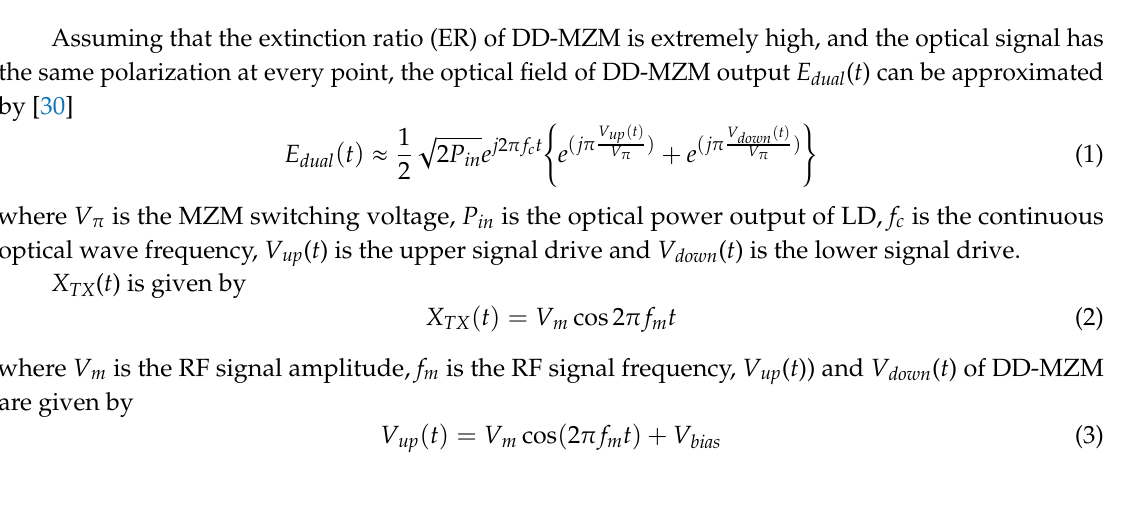
Figure 2. Basic configuration of DD-MZM to generate various modulation schemes.